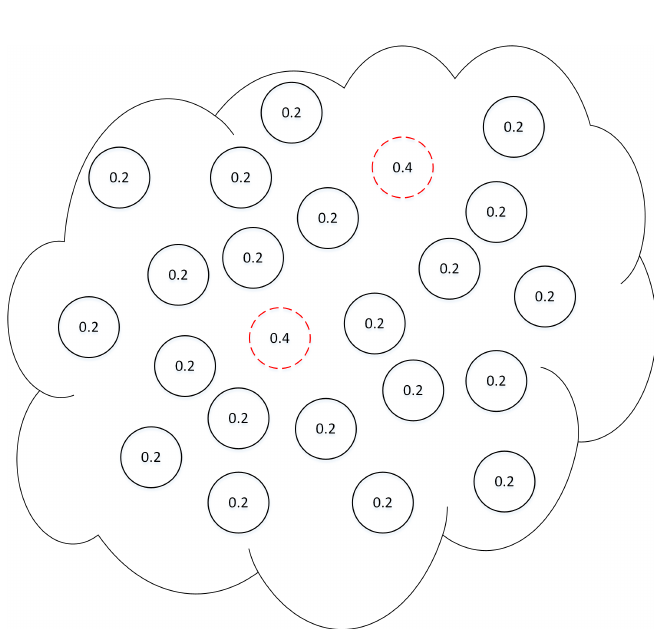
Figure 9. Solid circles indicate nodes with rate of 0.2 per second. Dashed circles indicate nodes with rate of 0.4 per second.